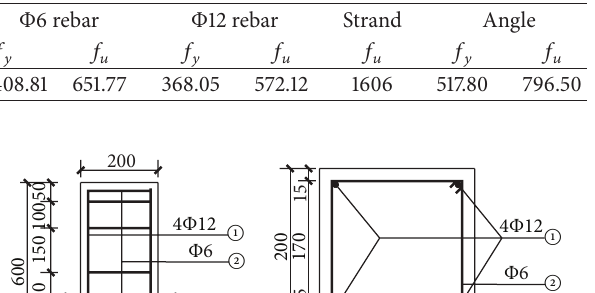
Table 1: Material strength of samples (MPa).